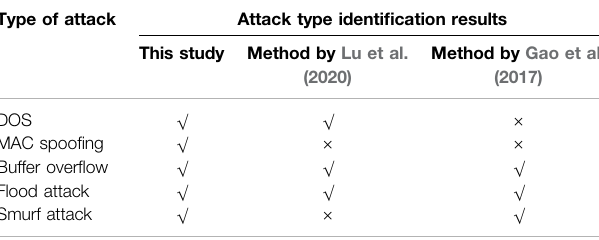
TABLE 3 | Comparison results of the number of identi fi ed attack